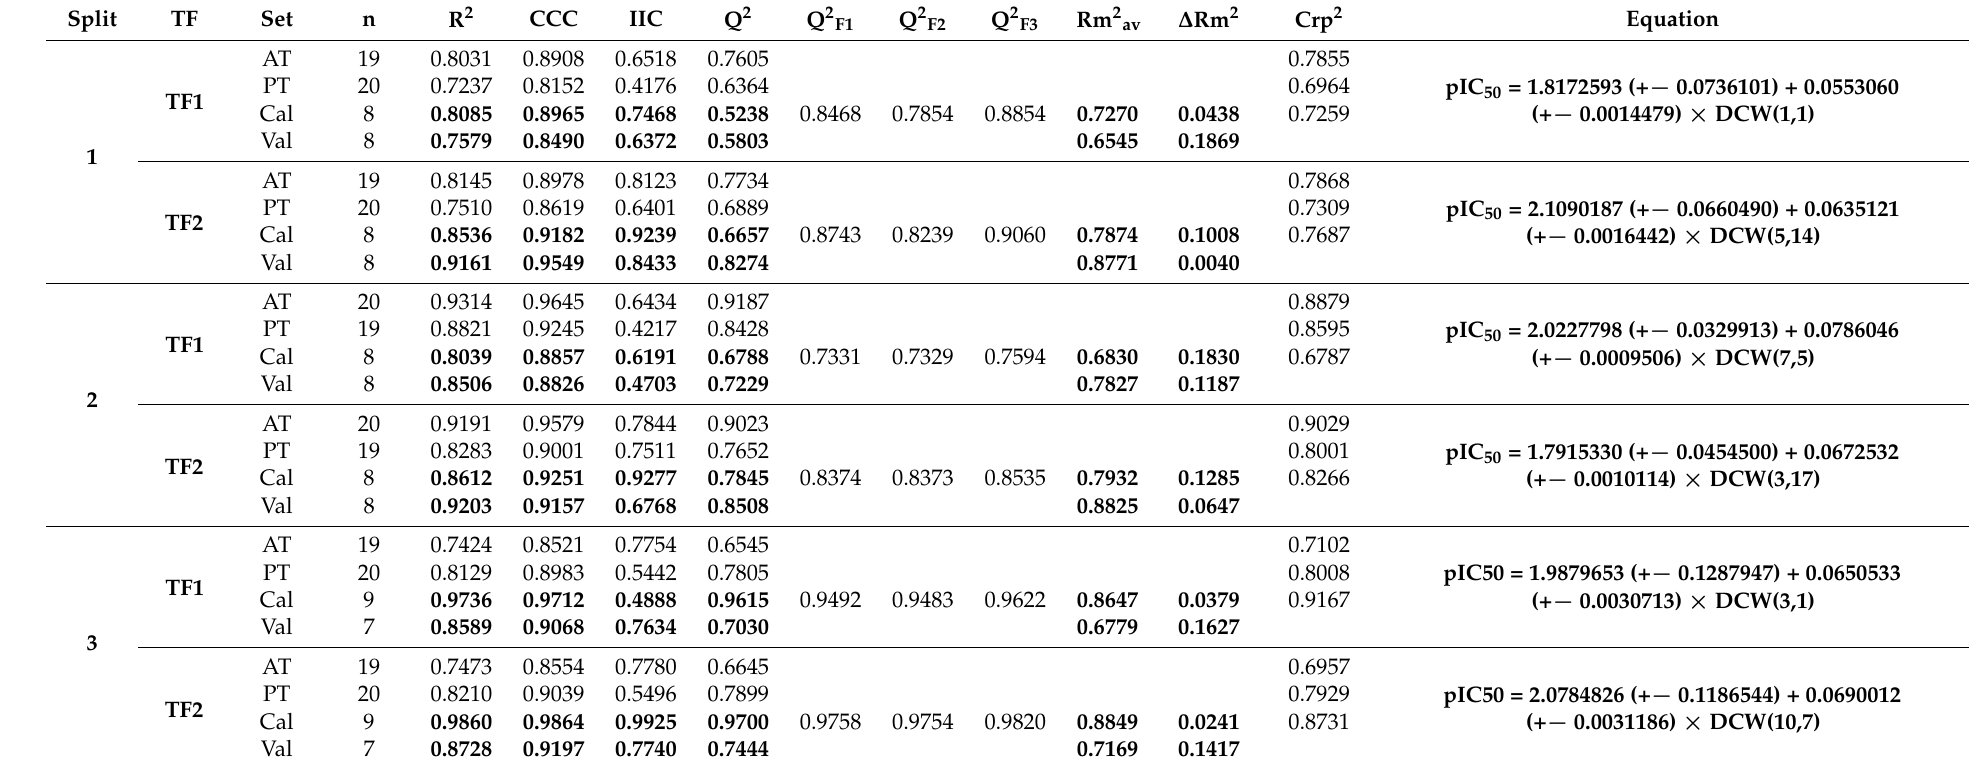
Table 1. Statistical parameters of built QSAR models and their corresponding